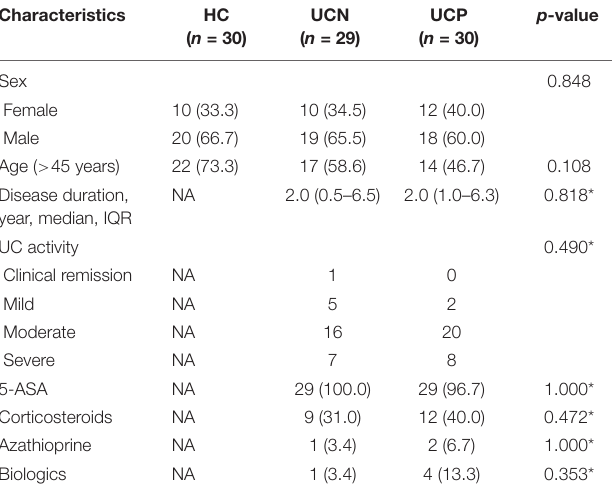
TABLE 1 | Characteristics of